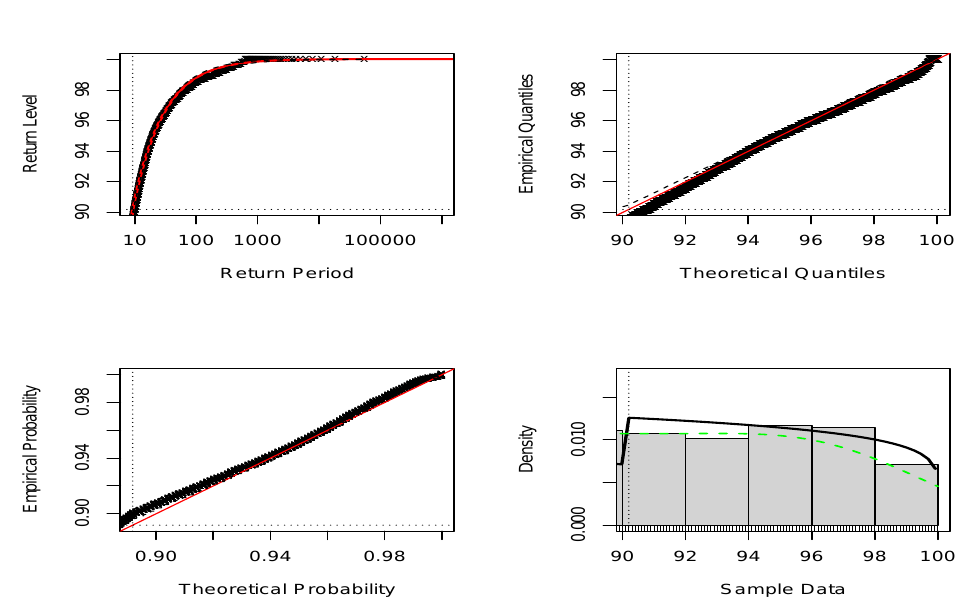
Figure A4. Diagnostic plots for fitted bulk model of relative humidity.